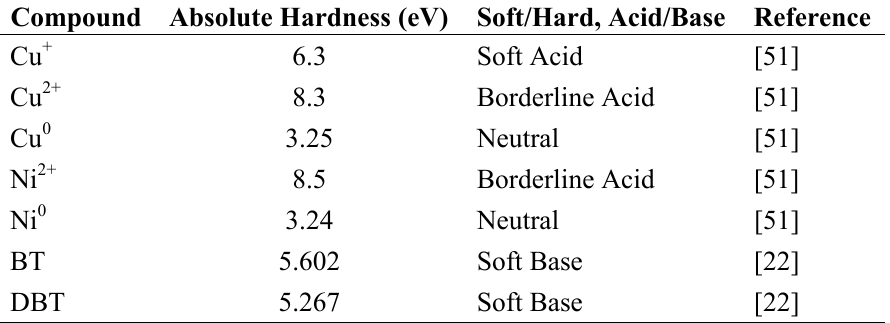
Table 3. Absolute hardness of copper/nickel oxidation states and thiophenic compounds based on Pearson